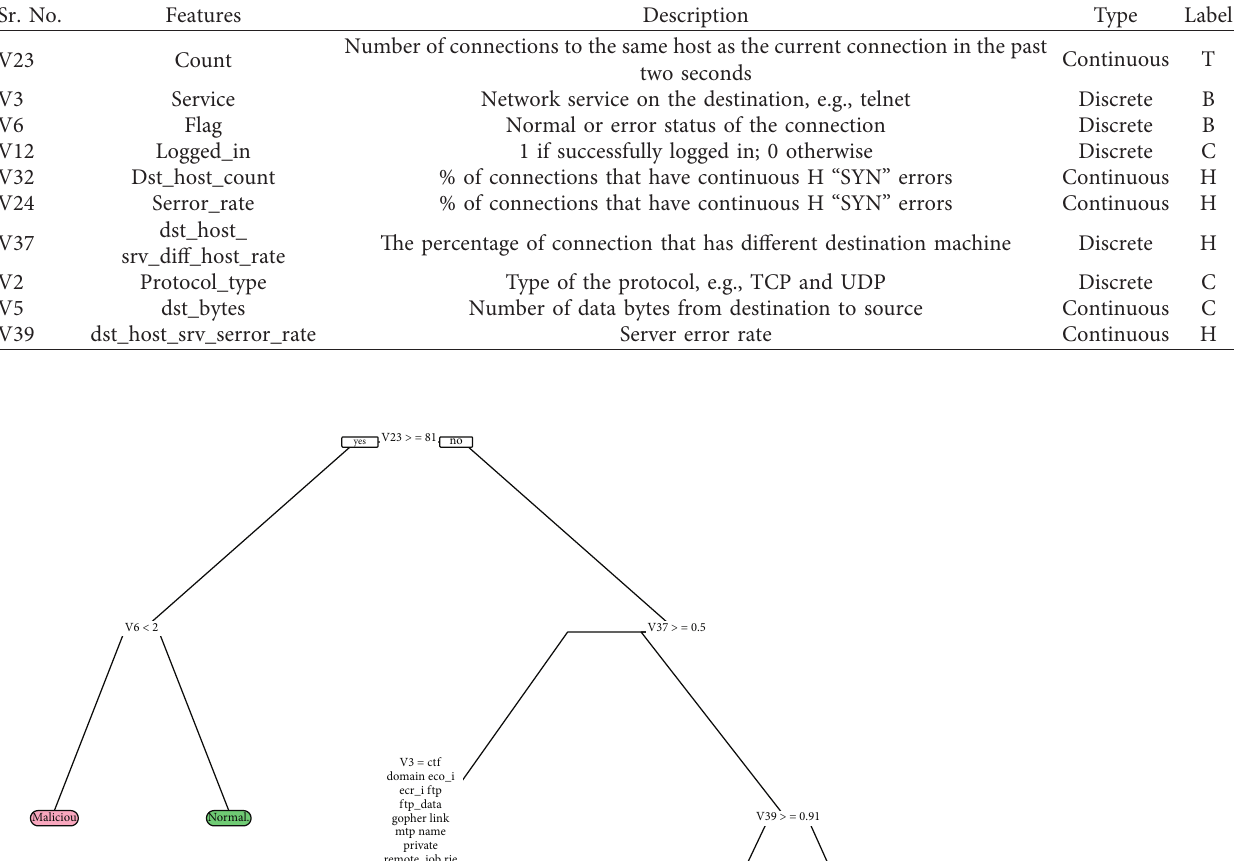
Table 2: Description of top ten features used in a decision